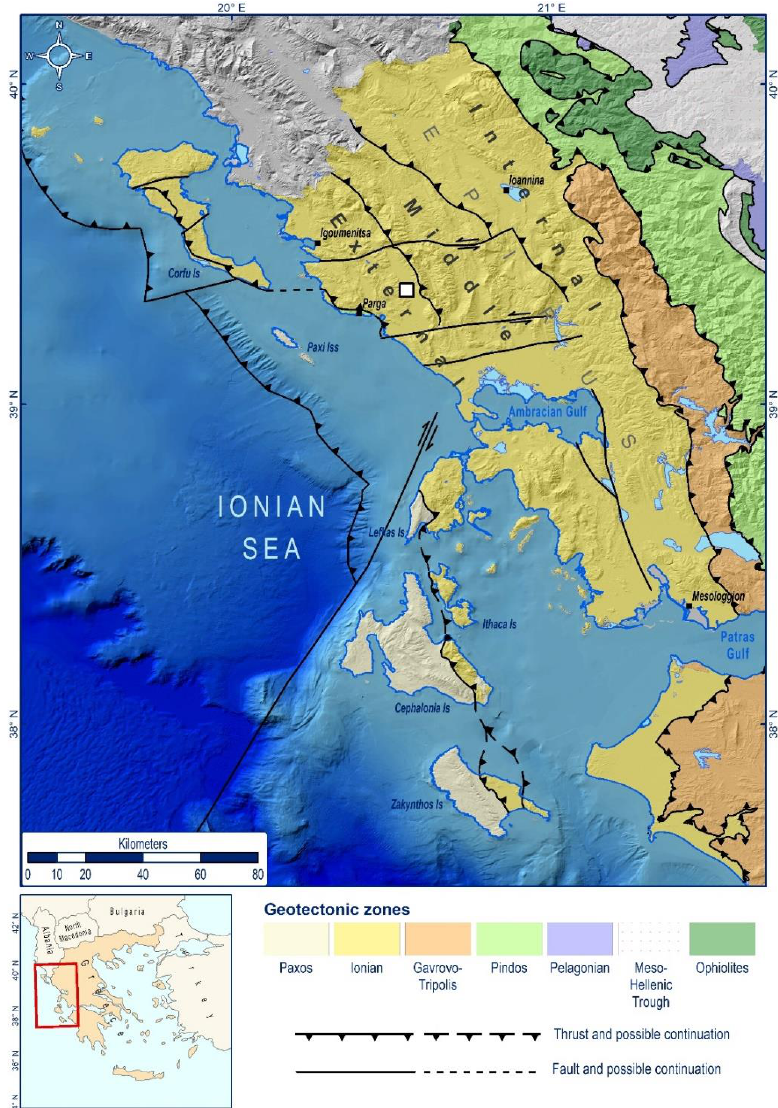
Figure 1. Geological map of the external Hellinides in Western Greece, illustrating the principal tectonostratigraphic zones: Pre-Apulian, Ionian, Gavrovo-Tripolis, and Pindos. The white square shows the location of the study section in external Ionian domain. Legend interpretations are pre- sented in the